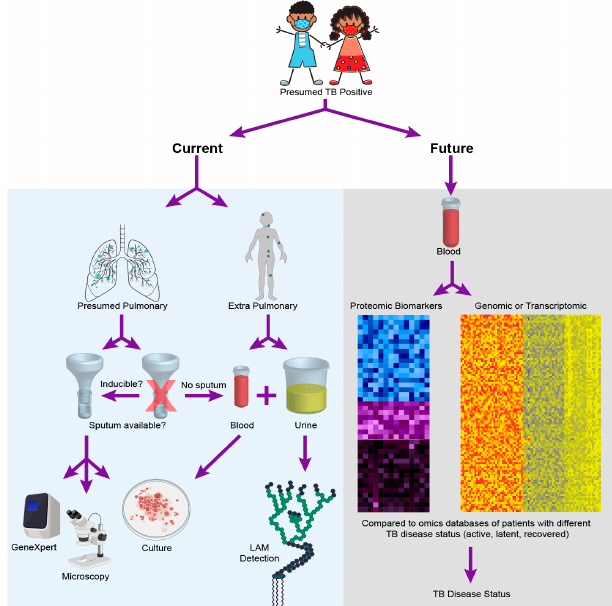
Figure 1. Pediatric tuberculosis (TB) diagnostics—today and tomorrow. The figure outlines the diagnostic choices and decisions that are made when a child is presumed positive for TB disease today, while highlighting that these choices and challenges may be entirely alleviated with the realization of empirical diagnostics as facilitated by one of the many potential omics strategies discussed in this review. To create the cumulative figure, images 379758506 by katy_k20 and 394943974 by janista were obtained from DepositPhotos and used under the standard license agreement. Additional images were downloaded from BioRender.com and used under licensed